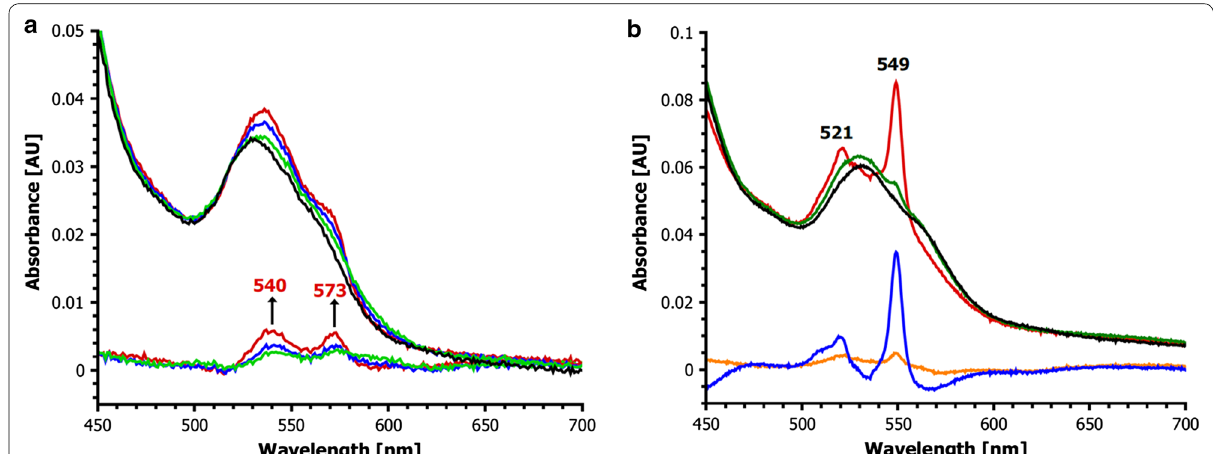
Fig. 5 UV–vis spectroscopical changes of deoxygenated (oxidized) RoxA by hydrogen peroxide. a UV–vis spectra of reoxidised (deoxygenated) RoxA-Wt (black) after incubation with a tenfold stoichiometric amount of hydrogen peroxide under aerobic conditions within 15 min (black to red) and the respective difference spectra minus reoxidised RoxA. Formerly oxidised RoxA is reoxygenated in consequence of an H 2 O 2 -dependent reduction of the N-terminal haem, visible as an increase of the absorption at 540 nm and 573 nm in the difference spectrum. b UV–vis spectra of reoxidised RoxA-Wt (black) incubated with 0.1 mM pyridine under aerobic conditions for 1 h (green). Subsequently, stoichiometric amounts of